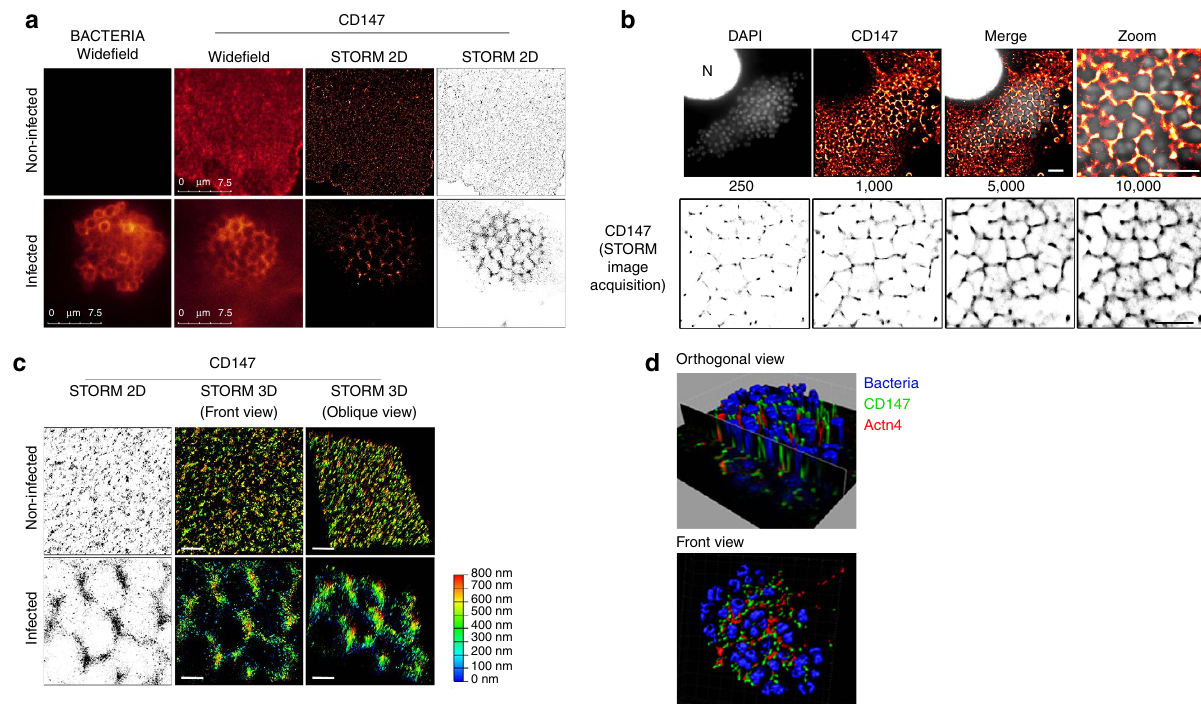
Figure 6 | a -Actn4 governs the spatial organization of CD147– b 2 AR complexes at bacterial adhesion sites. ( a and b ) CD147 organizes in dense clusters surrounding adherent bacteria. ( a ) HBMECs cells were non-infected or infected for 1h with meningococci, stained for bacteria and CD147, and analysed by widefield and STORM microscopy on a Leica SR GSD. Fifty thousand frames were recorded for each acquisition and reconstructed using the Leica Application Suite (LAS X) core module. ( b ) HBMECs cells infected for 1h with meningococci were stained for CD147 and 4,6-diamidino-2-phenylindole (DAPI) to visualize bacteria and cell nuclei (N); imaging was performed on a iMIC imaging work station. Ten thousand frames were recorded and reconstructed using QuickPALM 1.1 ImageJ plug (scale bar, 5 m m). Bottom: Typical STORM reconstruction sequence; legend indicates the number of acquired images used for reconstruction. ( c ) Comparative 2D- and 3D-STORM analysis of CD147 distribution at bacterial adhesion sites. HBMECs cells were infected for 1h with meningococci and stained for CD147. Images were acquired as in ( a ), on a Leica SR GSD. Shown are the 2D- and 3D-STORM reconstructions of CD147 clusters assembled at bacterial adhesion sites using the Leica LAS X 3D Visualization (scale bars, 1 m m) and the depth colour code (0–800nm). ( d ) 3D-SIM analysis of CD147 distribution at bacterial adhesion sites. 3D-SIM reconstruction of CD147 and Actn4 clusters at bacterial adhesion sites (scale bar, 2 m